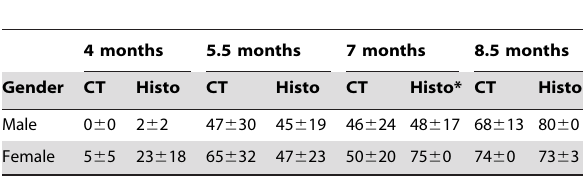
Table 2. Mean tumor volume for NDEA treated c-Myc transgenic mice separated by gender.